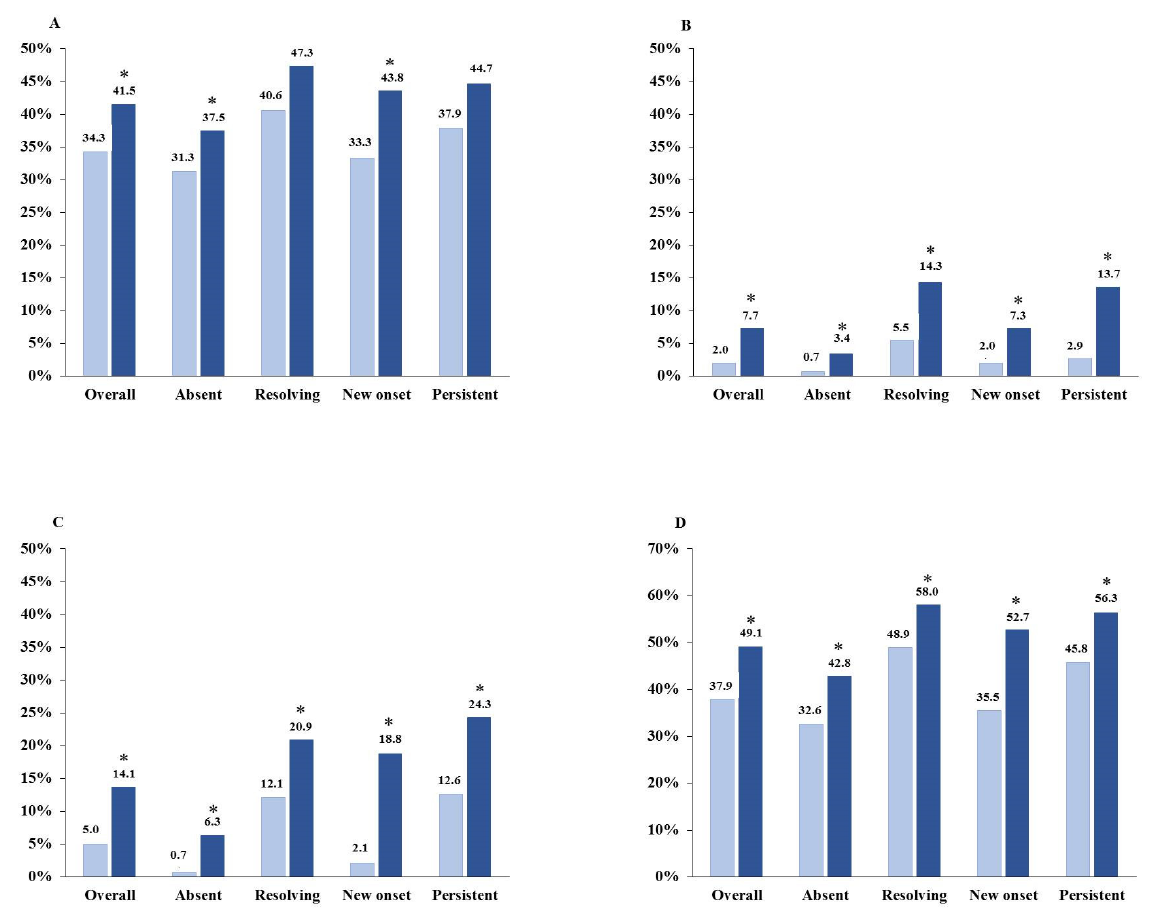
Figure 2. Anti-hyperkalemic therapy at baseline (light blue) and month-12 visit (dark blue): non-K sparing diuretics (panel A ), K-binders (panel B ), bicarbonate supplements (panel C ), and at least one of the three drugs (panel D ) in the whole cohort and in each HK subgroup (see text for definition and size of subgroups). * p < 0.05 vs. baseline.